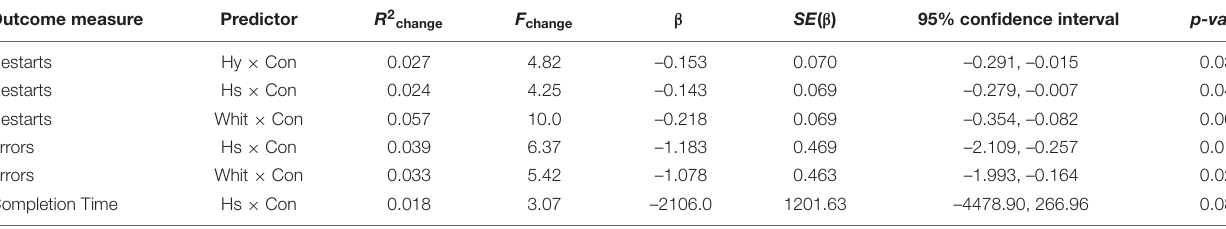
TABLE 3 | Significant interactions for cognitive performance on Trails A outcomes.